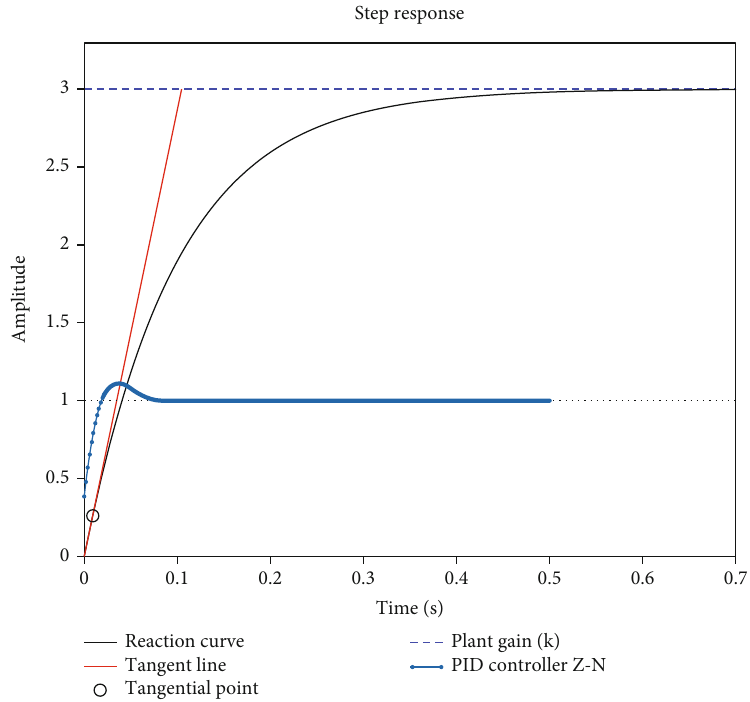
Figure 9: Reaction curve or a